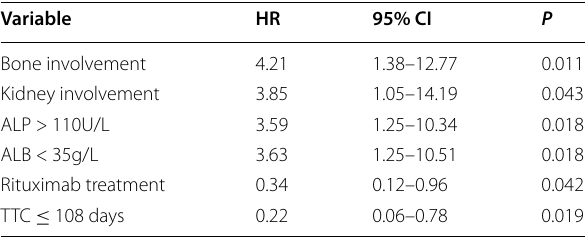
Table 3 Multivariate analysis of risk factors for CNS relapse in the entire cohort